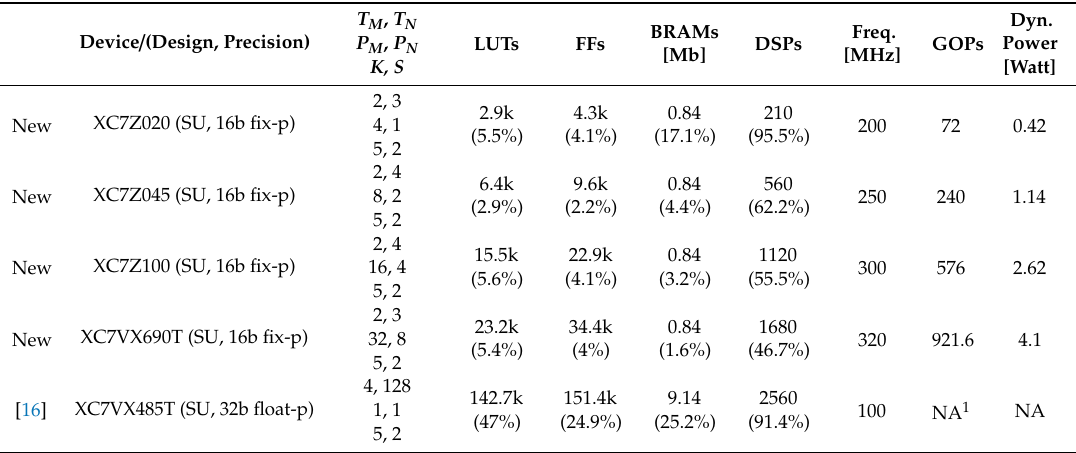
Table 1. Comparison